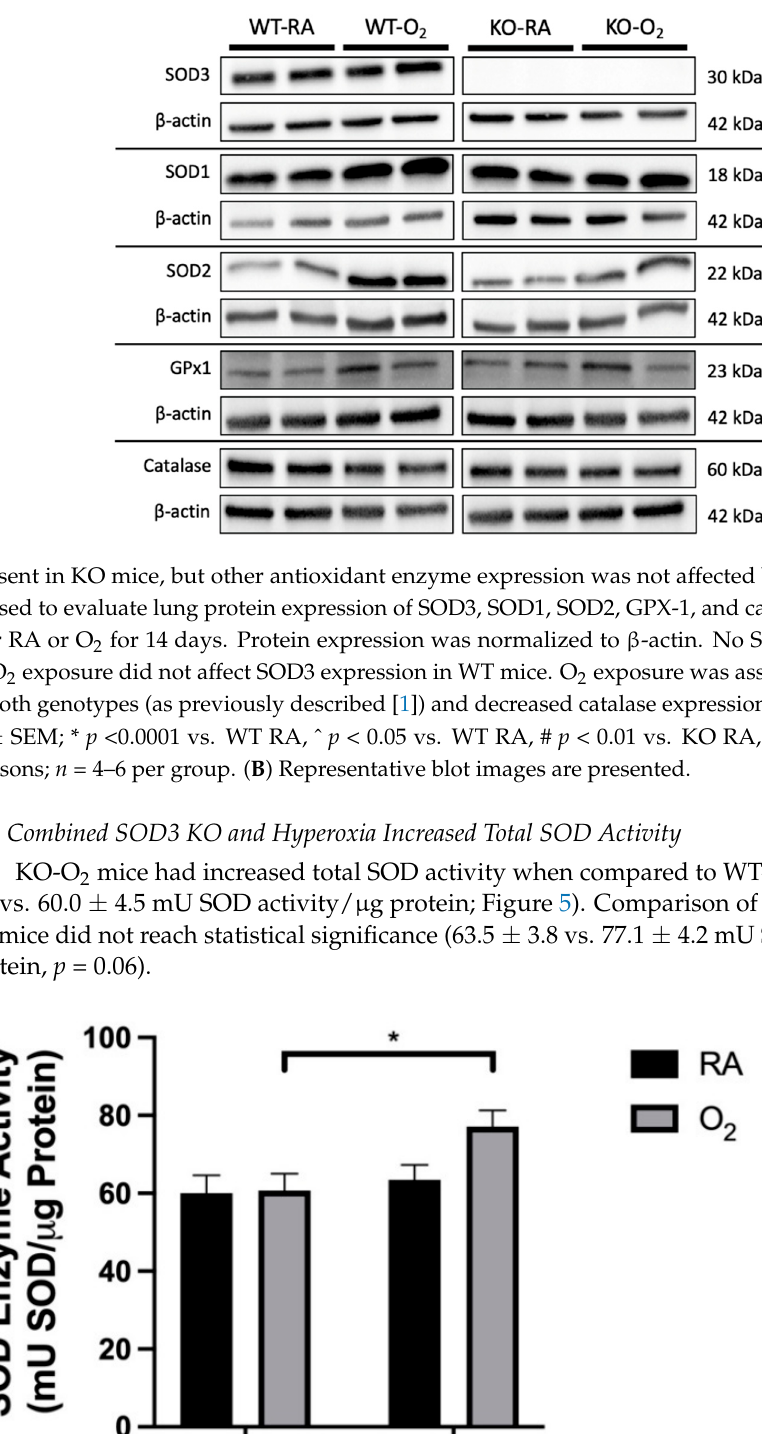
Figure 5. Total SOD activity was increased in KO-O 2 mice. SOD activity was measured as the rate of elimination of superoxide compared to standard concentrations of SOD enzyme. Whole-lung SOD enzyme activity was increased only in KO-O 2 mice. Data are presented as means ± SEM; * p < 0.05 vs. WT O 2 ; n = 6–9 per group.